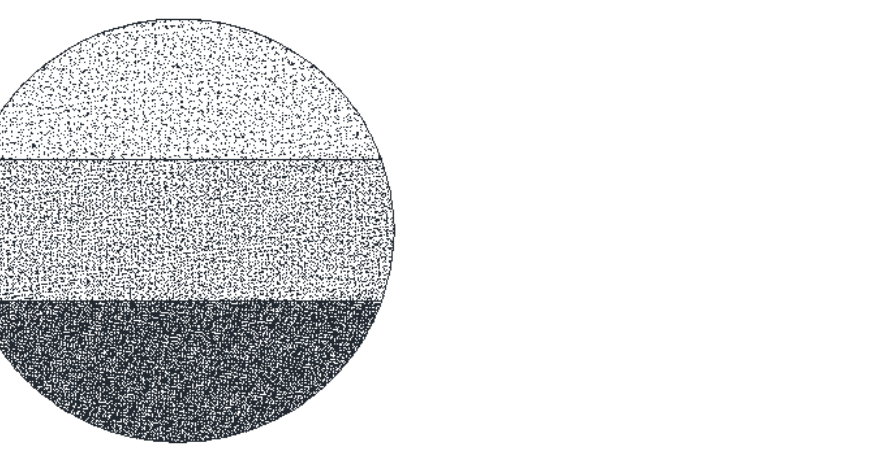
Figure 1. Schematic diagram of reverse rhythm reservoir. Note: The darker the color, the denser the layer.